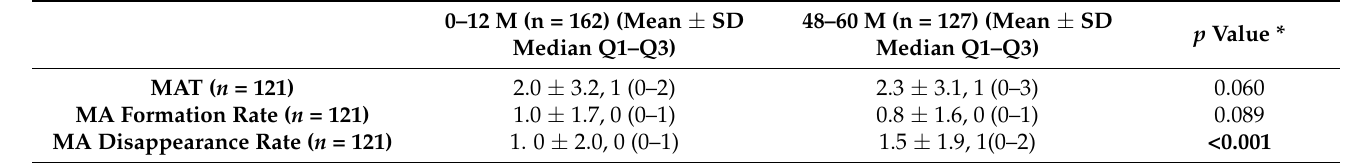
Table 4. Comparison between MAT, formation, and disappearance rate in the first year and last year of the 5-year period of